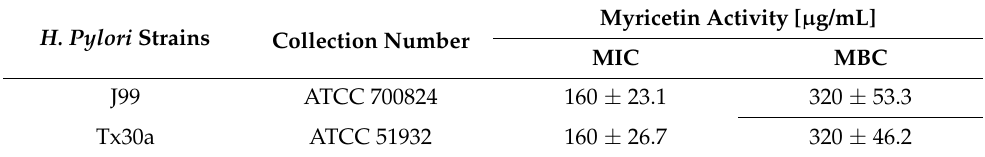
Table 1. Antibacterial activity of myricetin against tested Helicobacter pylori strains. H. Pylori